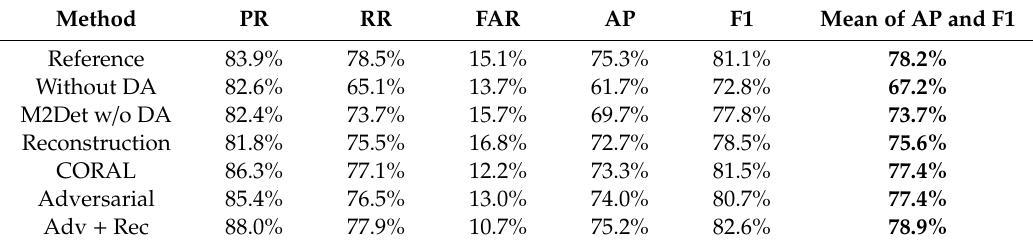
Table 2. Detection performance of each method. PR: precision rate, RR: recall rate, FR: false alarm rate.